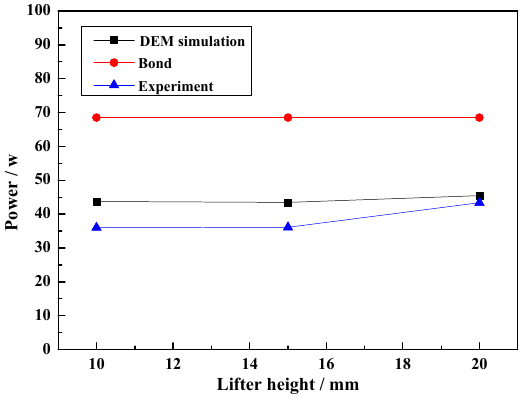
Figure 13. Power draw at different lifter heights.